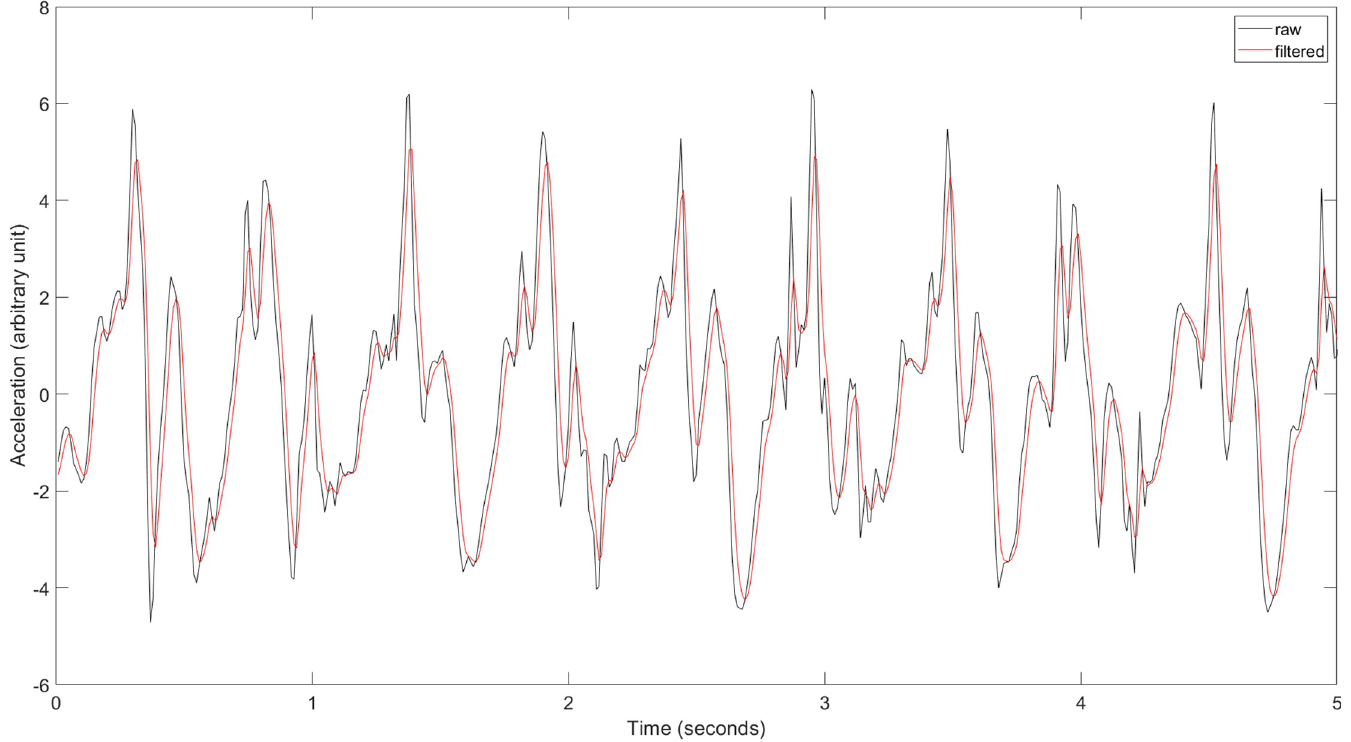
Fig 4. Example signal from raw ang low-pass filtered walking signal, from the x-axis accelerometer.